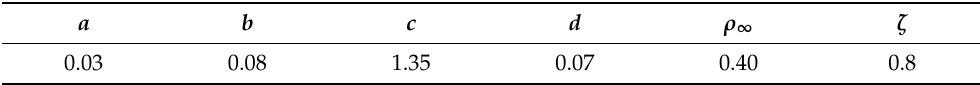
Table 1. Summary of the DLFM volatility and correlation input